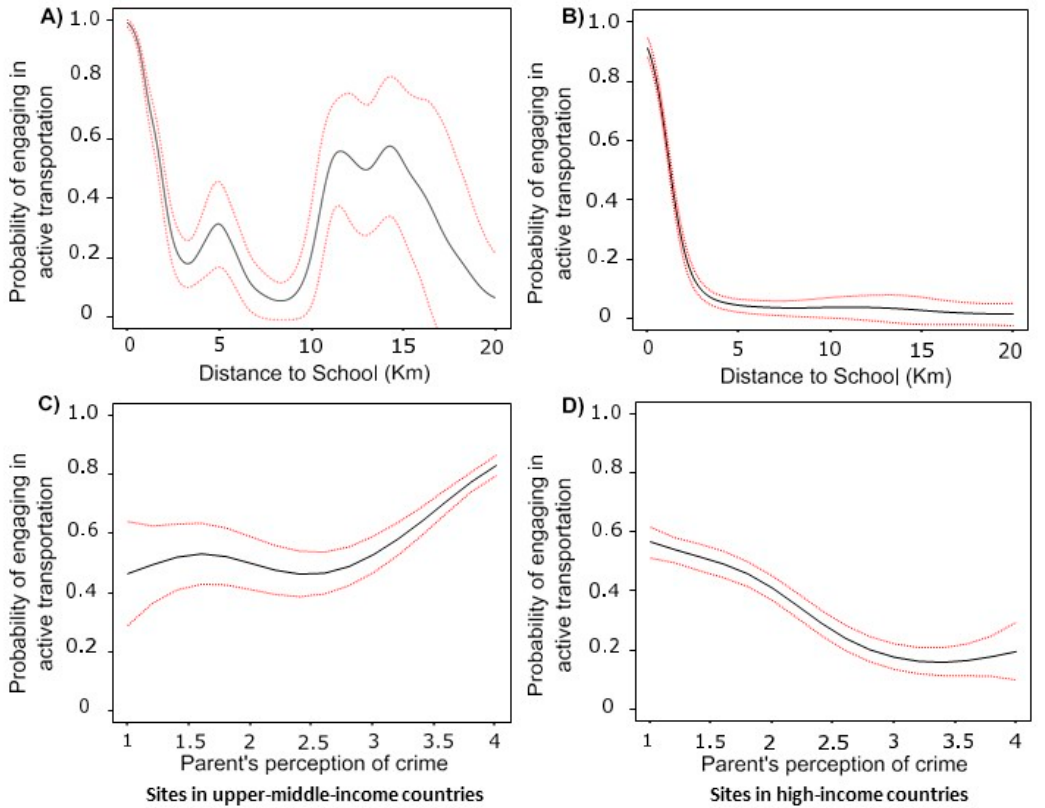
Figure 1. Associations of active transport to school with distance and crime perception by income level of the country. ( A ) Association of active transportation to school with distance between home and school among children from sites in upper middle-income countries. ( B ) Association of active transportation to school with distance between home and school among children from sites in high-income countries. ( C ) Association of active transportation to school with parental perception of crime in sites in upper middle-income countries. ( D ) Association of active transportation to school with parental perception of crime in sites in high-income